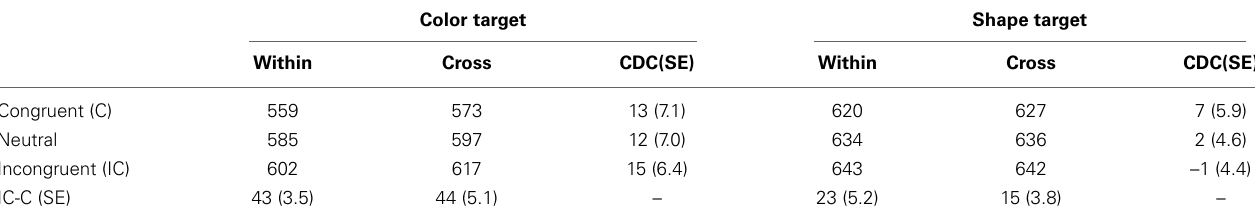
Table 1 | RTs (in milliseconds) and standard errors (SEs, in parentheses) in Experiment 1.